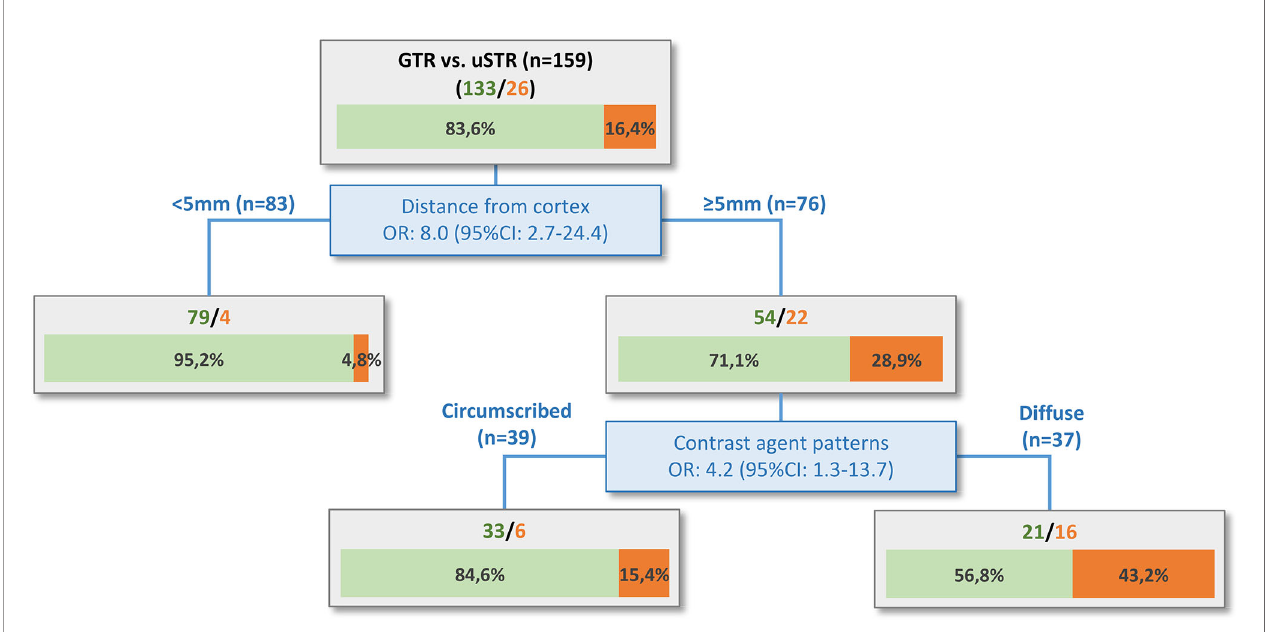
FIGURE 3 | Regression tree analysis. The distance of the metastasis from the cortex is the most relevant risk factor, with 5mm being the cut-off value for higher (28.9%) or lower (4.8%) probability of an uSTR. The risk for patients with metastasis ≥ 5mm distant from cortex can be further strati fi ed based on the contrast agent patterns. Subcortical metastases with clear margins to the healthy brain tissue and round, circumscribed contrast agent enhancement without fi liform/ fi nger-shaped spreading had a lower risk (15.4%) for an uSTR. In contrast, subcortical metastases with diffuse contrast agent enhancement had the highest risk (43.2%) for an uSTR. The tree diagram also shows the individual odds ratios (OR) with 95% con fi dence interval (95%CI) of the